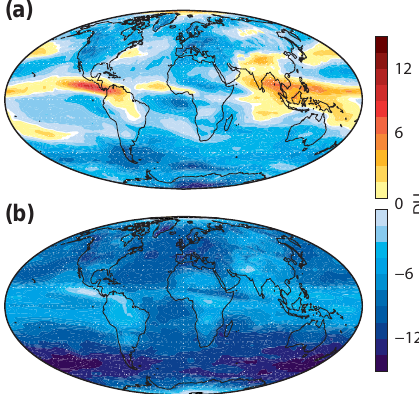
Figure 7. TCO 3 mean differences between the analyses from Exp/Ctrl and those from Exp/GOME2 (a) and Exp/MIPAS (b) com- puted for the period August–October 2008. Negative (positive) val- ues in blue (red) colours mean that the additional instrument is in- creasing (decreasing) the TCO 3 amount compared to that obtained from the ozone datasets assimilated in Exp/Ctrl. Data are in DU. The colour scale ranges from − 15DU (dark blue) to + 15DU (dark red) with a step of